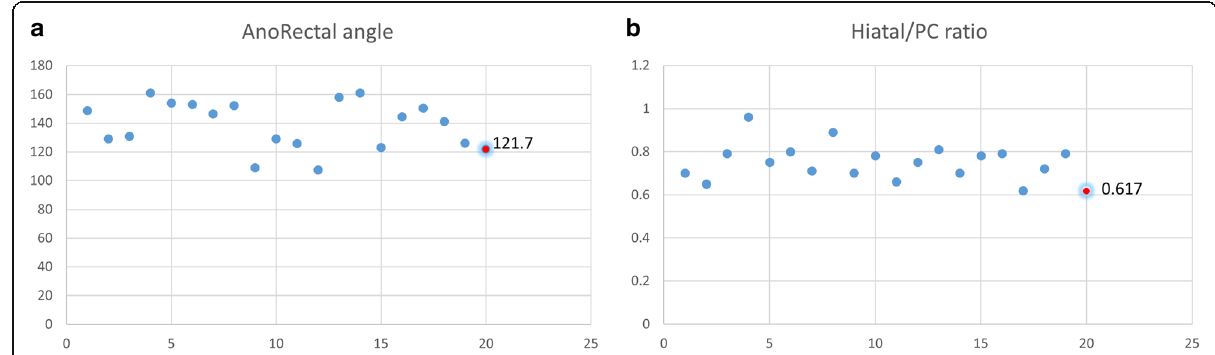
Fig. 4 Scatter plot demonstrating values of anorectal angle and hiatal/PC ratio of the 19 cases that were generally higher than previously determined cut-off values to differentiate between good and poor continence scores after PSARP. The cut-off values are represented by red spot (marker) on the graph (121.7 for anorectal angle, and 0.617 for hiatal/PC ratio)